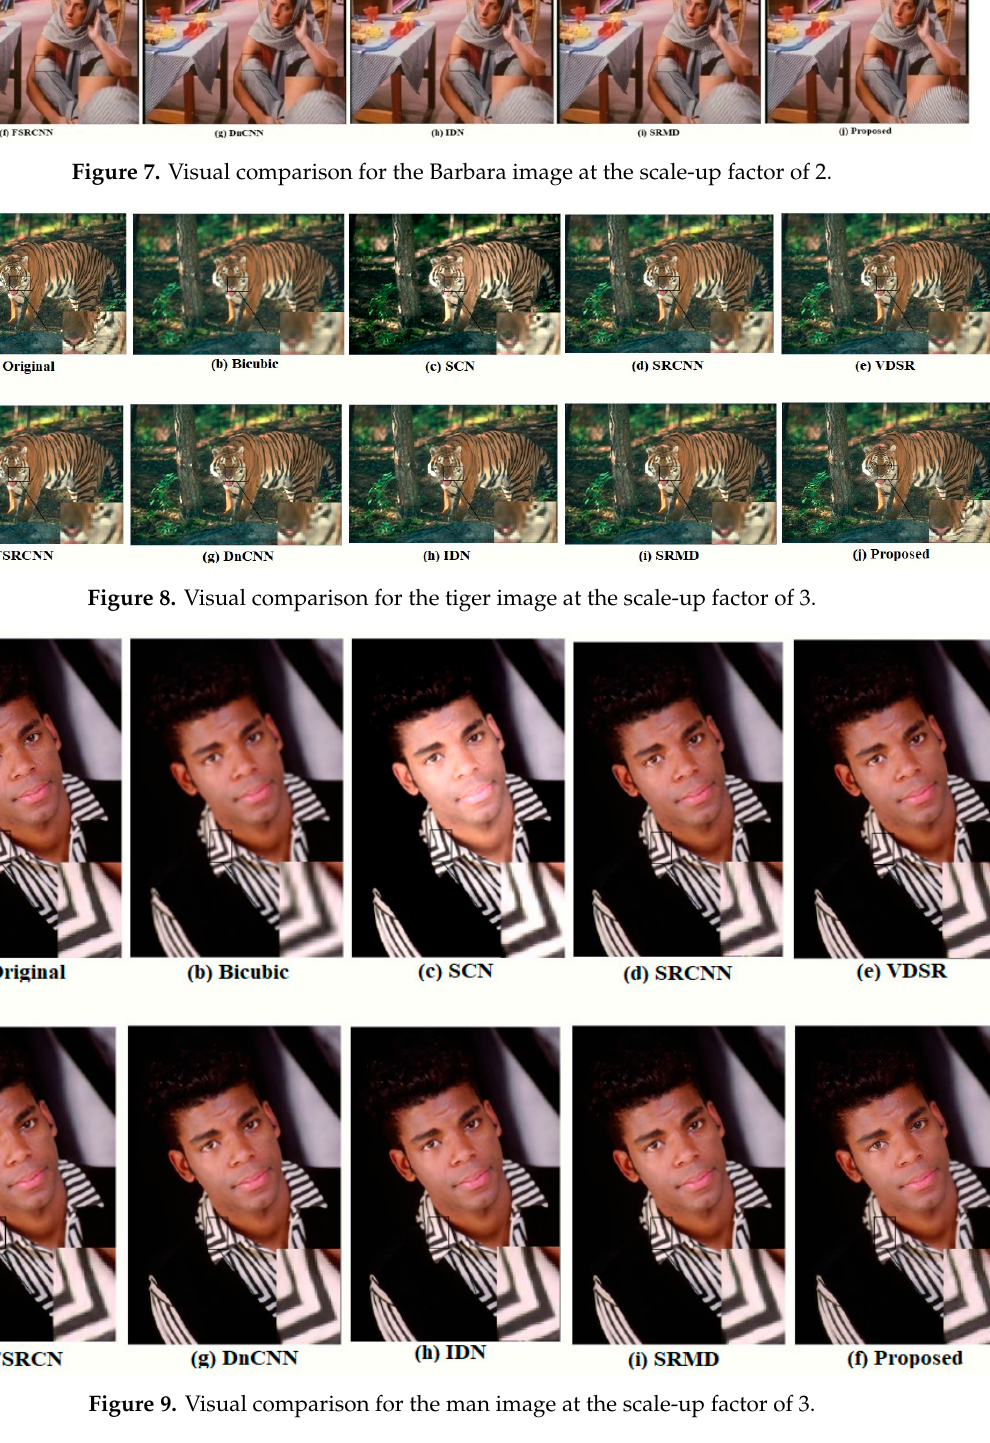
Figure 10. Visual comparison for the Urban04 image at the scale-up factor of 4. Figure 11. Visual comparison for the Urban73 image at the scale-up factor of 4.